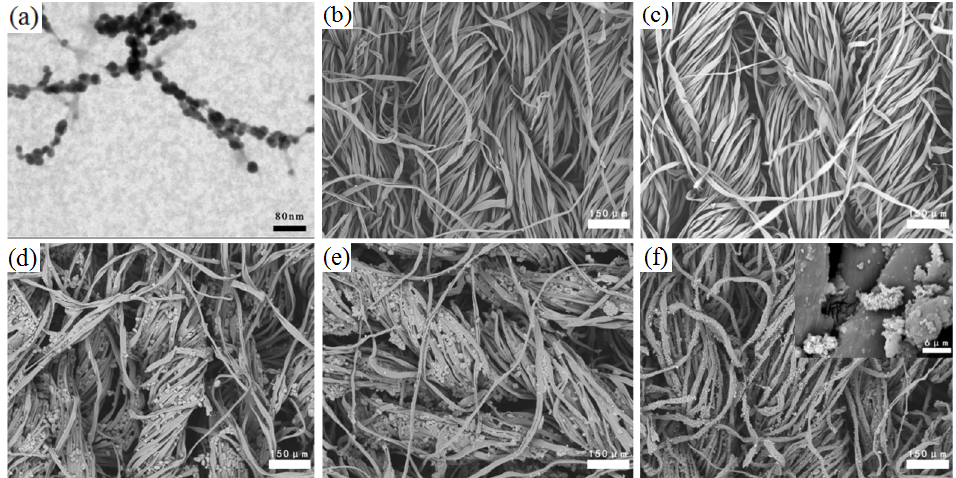
Figure 2. STEM image of ( a ) CNC-SiO 2 rods; SEM images of the ( b ) pure cotton, ( c ) B cotton, ( d ) BA cotton, ( e ) BAP cotton, and ( f ) BAPC cotton including high magnification inset.